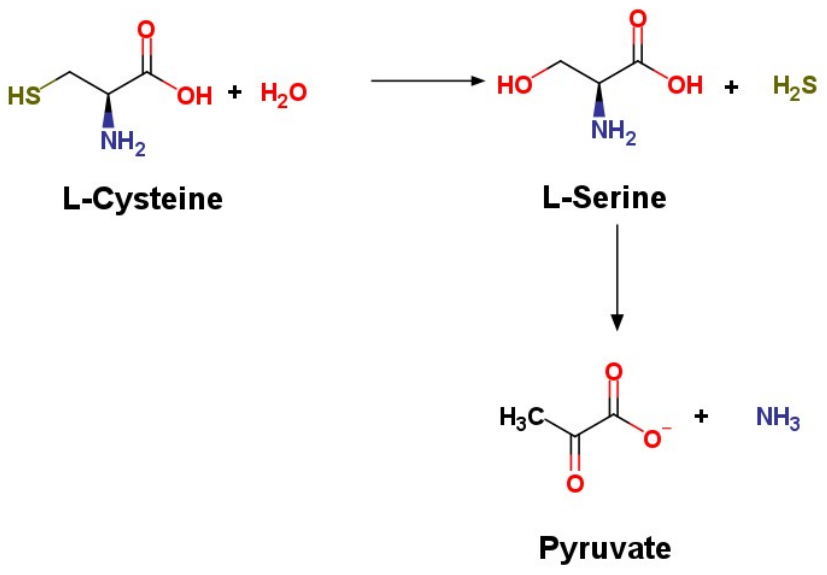
Figure 1. H 2 S synthesis via CSE.